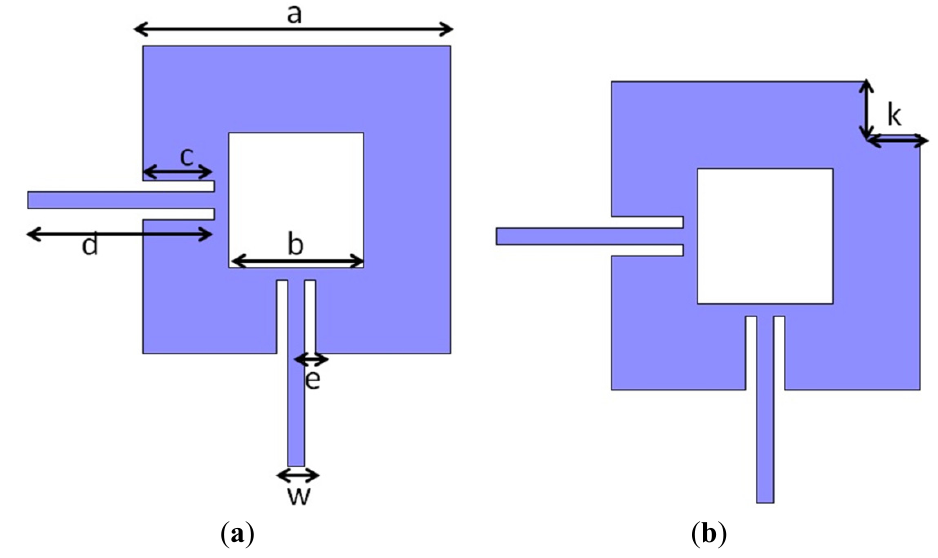
Figure 1. Geometry of a microstrip square patch resonator with a central square notch (dual-mode). ( a ) Without any additional cut; ( b ) With a square cut on a specific